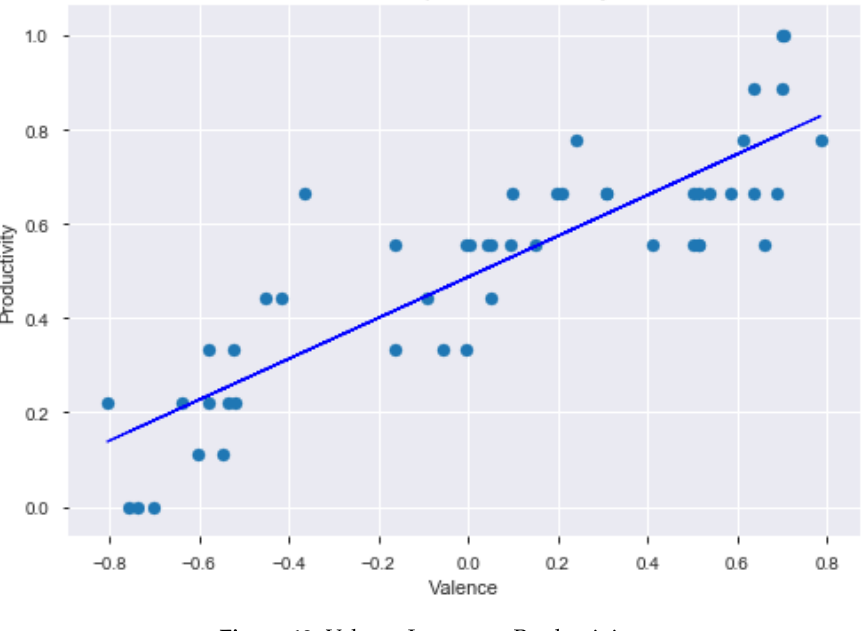
Figure 12. Valence Impact on Productivity.